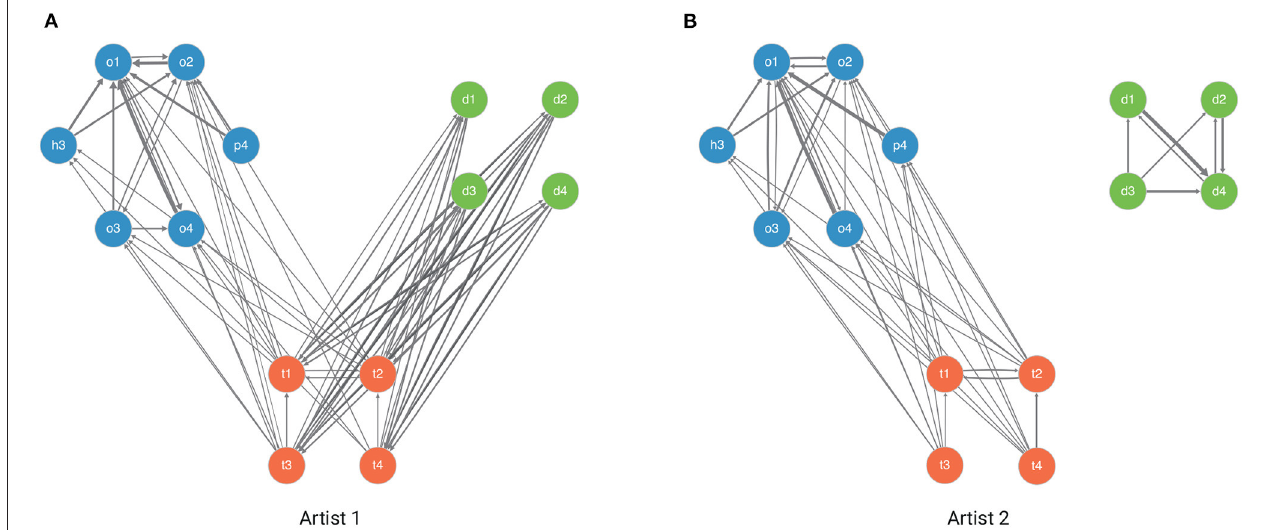
FIGURE 4 | Estimated individual-level transitions between orthogonal, diagonal and transitional gestures for two example artists. Each panel represents an example artist ( A : artist 1, B : artist 2) with her corresponding estimated transition probabilities between gestures. The width of the edges reflects the probability of transition, whereby a wider or bolder edge implies an increased probability of transition. Self-loops are not